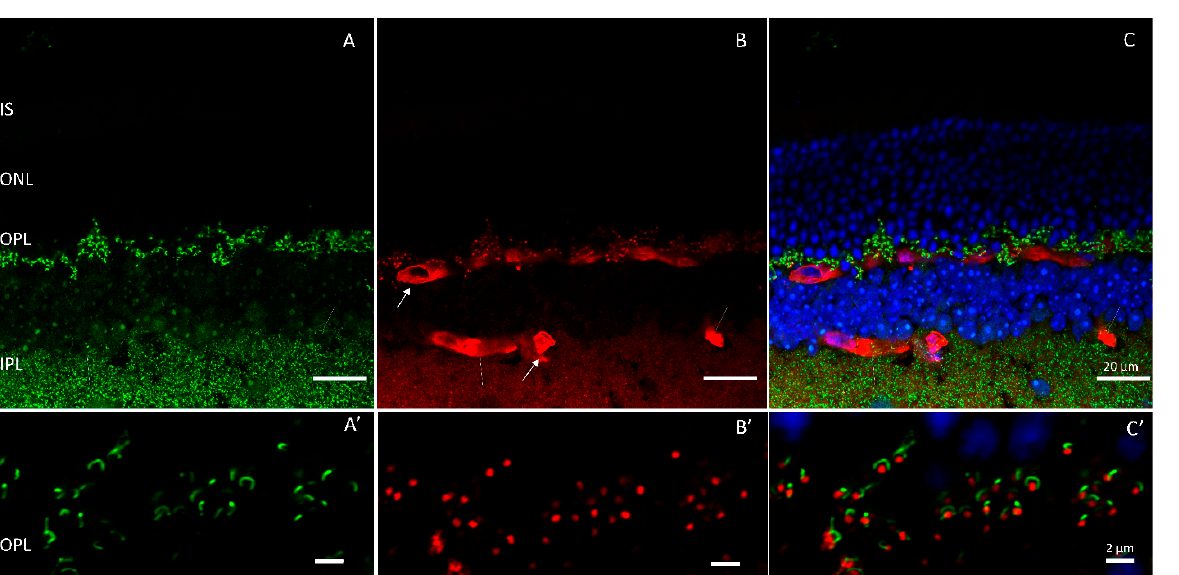
Figure 6. Dystrophin expression in the mouse retina is localized to the outer plexiform layer of the retina where it complexes with dystroglycan. Shown is antibody staining of an adult wildtype mouse retina labeled with ( A ) Ribeye (green) and ( B ) dystrophin (red). ( C ). Merged. Outer plexi- form layer shown in ( A’ – C’ ). Scale bar = 20 µm in ( A – C ) and 5µm in ( A’ – C’ ).